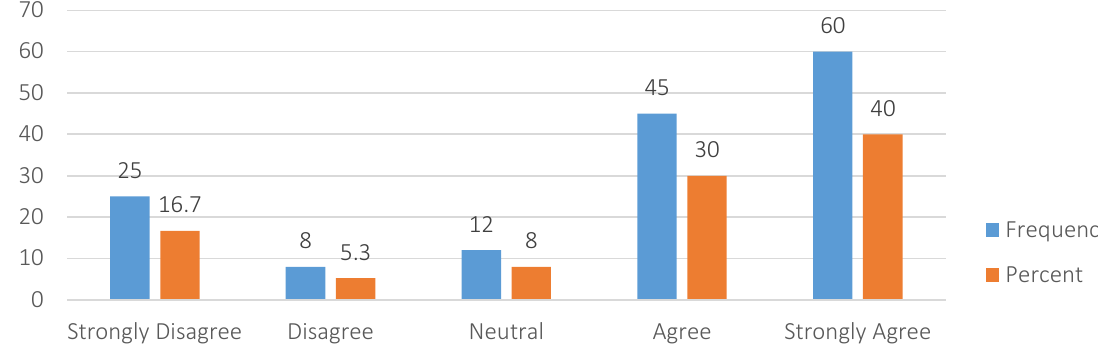
Figure 6. Technology adoption and the usage of MAPs are key innovative strategies for business